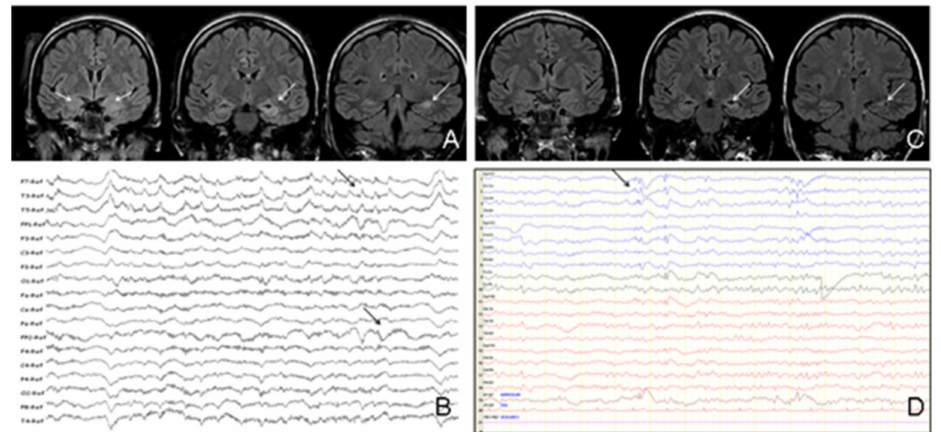
Figure 2. ( A ) Initial brain MRI of one patient with AE due to NMDAR Ab (acute phase). Coronal fluid- attenuated inversion recovery (FLAIR) sequences showing bilateral amygdalar and left hippocampus hyperintensities and increased volume of both structures (white arrows). ( B ) Initial EEG of the same patient (acute phase). Reference montage showing IED over the left frontotemporal region and generalised beta activity (black arrows). ( C ) Control brain MRI of the same patient after resolution of AE. Coronal FLAIR sequences showing persistence of hyperintensity in left hippocampus and development of hippocampal atrophy (mainly in the tail) (white arrows). ( D ) Control EEG of the same patient after resolution of AE. Bipolar montage showing IED over the left frontotemporal region (black